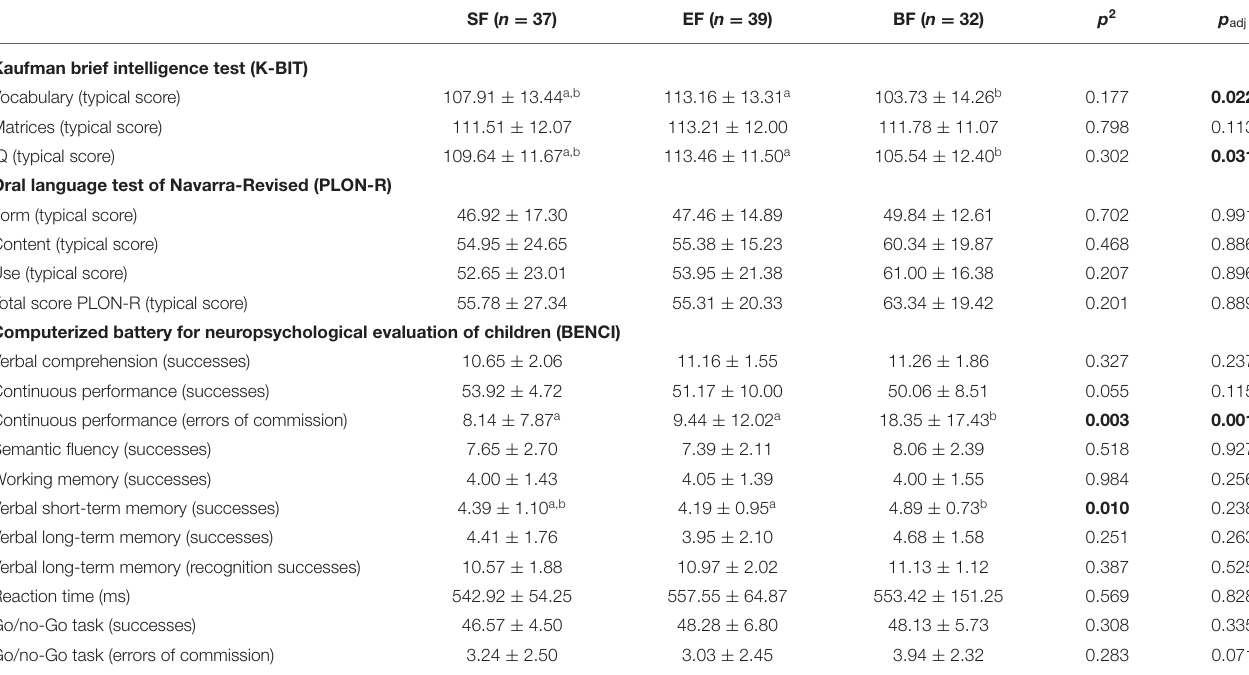
TABLE 2 | Children’s neurocognitive function at 6 years old depending on the type of feeding during infancy 1